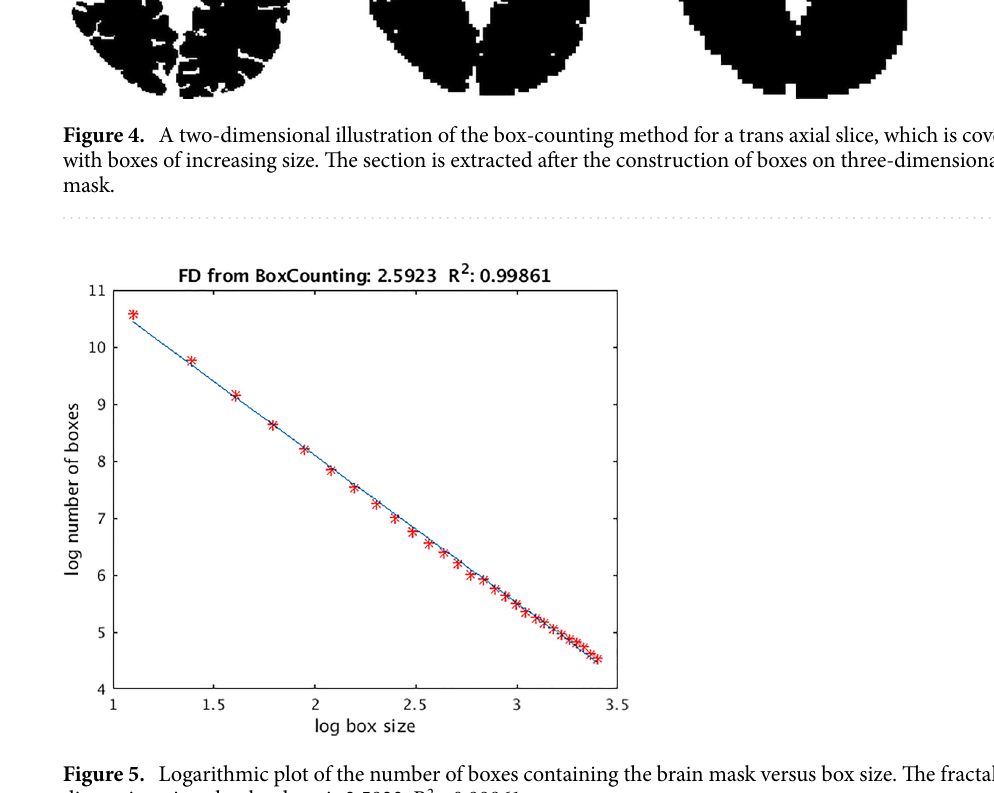
Figure 5. Logarithmic plot of the number of boxes containing the brain mask versus box size. The fractal dimension given by the slope is 2.5923, R 2 =